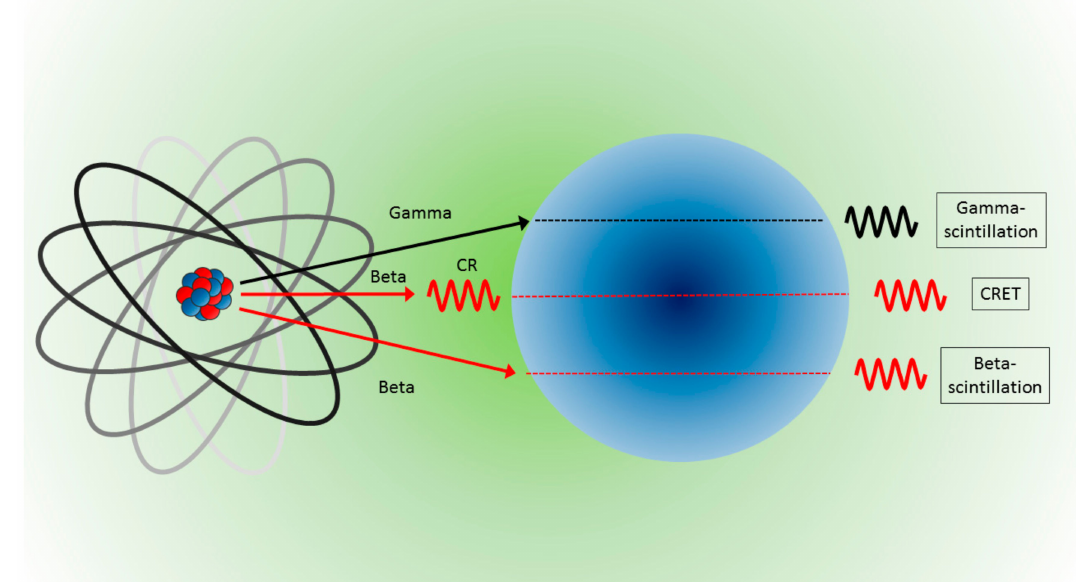
Figure 3. Light produced from NPs and the interaction with radionuclides are due to gamma rays which produce gamma scintillation ( top ), interactions with photons (Cerenkov radiation) which are converted by CRET ( middle ), and direct interactions with beta particles which produce beta scintillation ( bottom